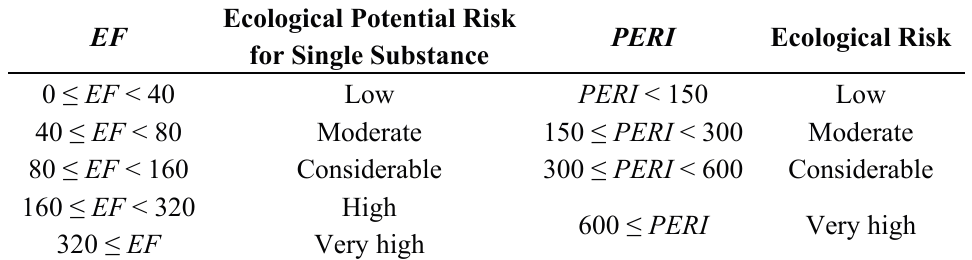
Table 2. Monomial potential ecological risk factor ( EF ) and Potential ecological risk index ( PERI ) classification levels [62]. Ecological Potential Risk EF PERI Ecological for Single Substance